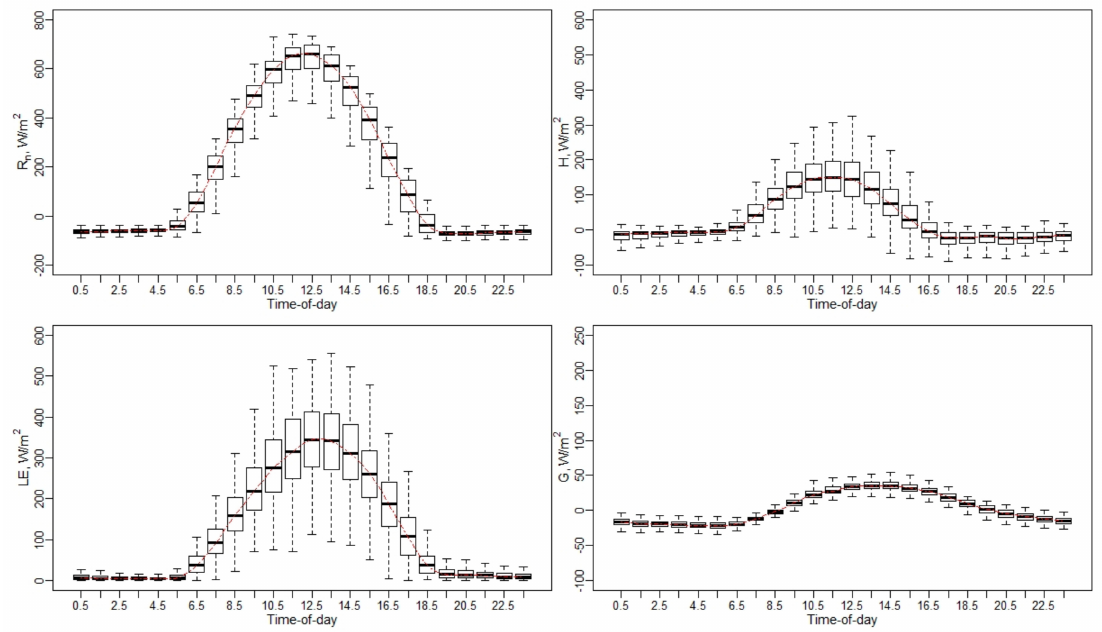
Figure A5. Diurnal variation of surface energy fluxes ( R n , H , LE , and G ).